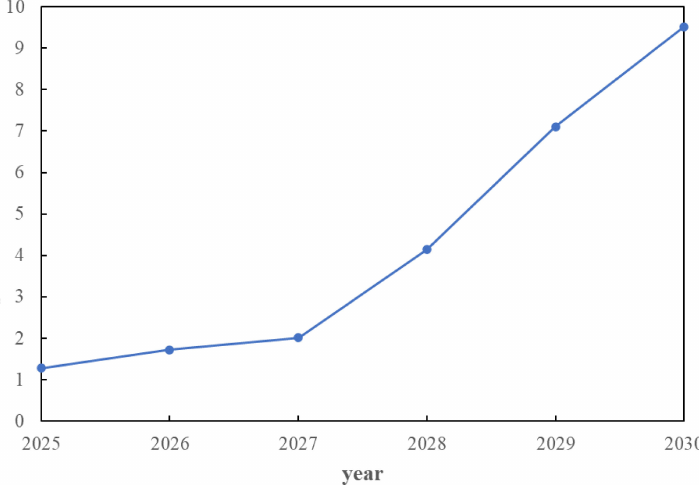
Figure 24. Interactive power between distribution network and main network from 2025 to 2030